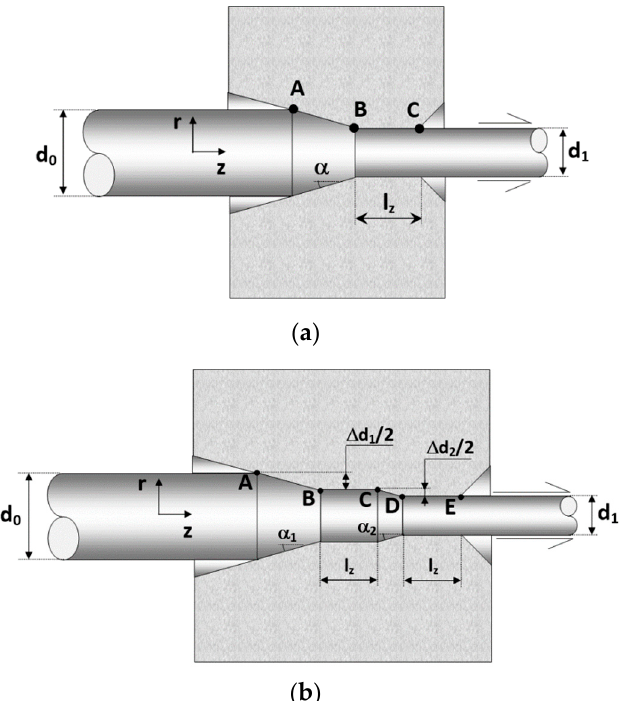
Figure 1. Scheme of ( a ) conventional wire drawing die and ( b ) a wire drawing die including a skin pass zone after the bearing length of the main reduction.